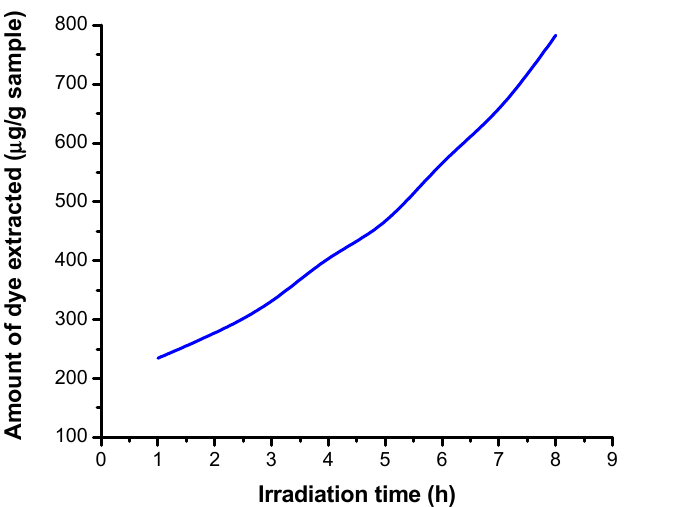
Figure 13. Dependence of the extracted 5% dye concentration on the irradiation time in an alkaline medium.